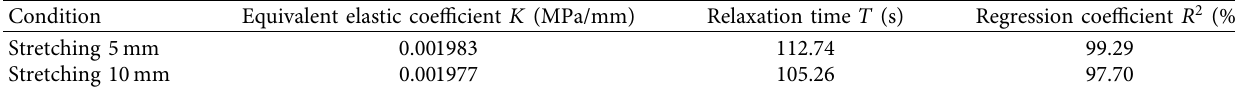
Figure 4: Mechanical responses of composite gels under stress relaxation: (a) strain history of composite gels under stress relaxation and (b) stress history of composite gels under stress relaxation. Table 1: Rheological parameters.